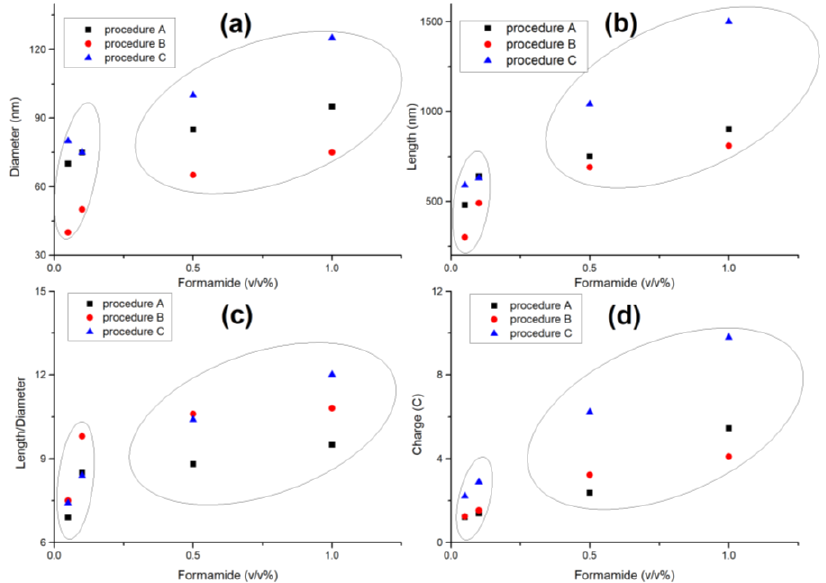
Figure 6. Diameter ( a ), length ( b ), and aspect ratio ( c ) of the ZnO nanorods as well as the charge ( d ) transferred during electrodeposition for each of the three procedures A, B and C.